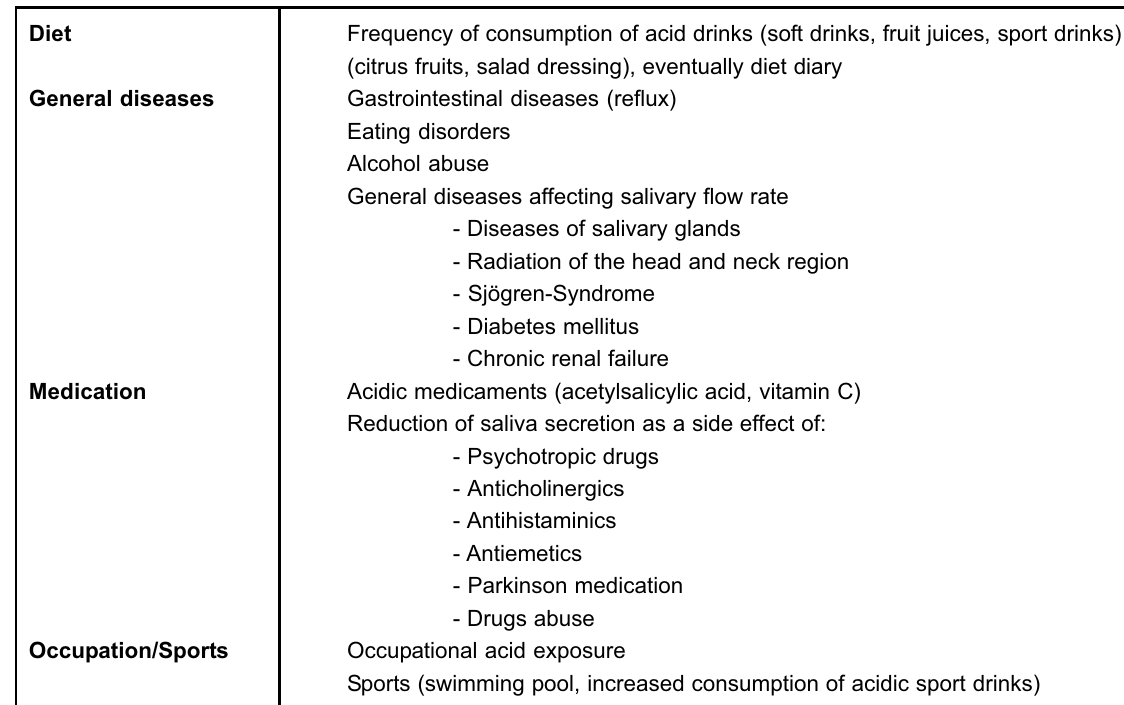
FIGURE 4- Factors retrieved from a clinical interview indicating an increased risk for dental